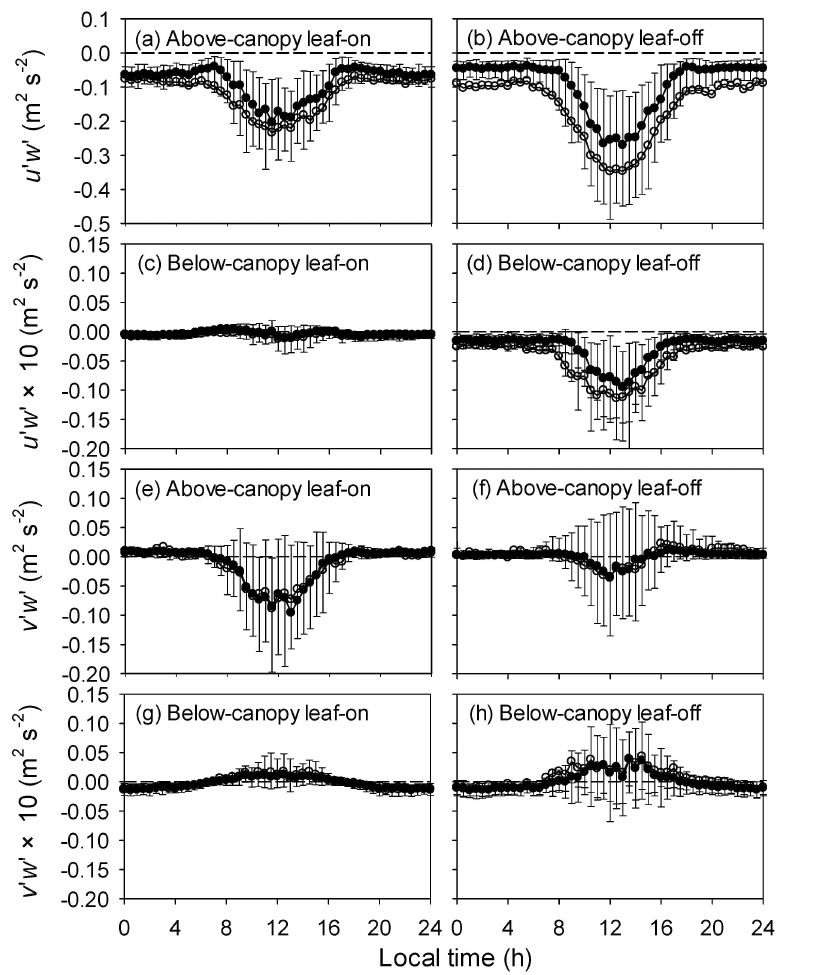
Figure 7. Diurnal courses of Reynolds stress components above (48 m) and bellow (2 m) the canopy during the leaf-on and leaf-off seasons of 2012. ( a )–( d ): longitudinal Reynolds stress, (a) 36 m for leaf-on season, (b) 36 m for leaf-off season, (c) 2 m for leaf-on season, and (d) 2 m for leaf-off season, ( e )–( h ): lateral Reynolds stress, (e) 36 m for leaf-on season, (f) 36 m for leaf-off season, (g) 2 m for leaf-on season, and (h) 2 m for leaf-off season. Open circles are mean values, filled circles are the median and error bars indicate the range between the 25 and 75 percentile, respectively. The dashed lines are zero gradient. Note the different vertical axis in the upper-most row of the